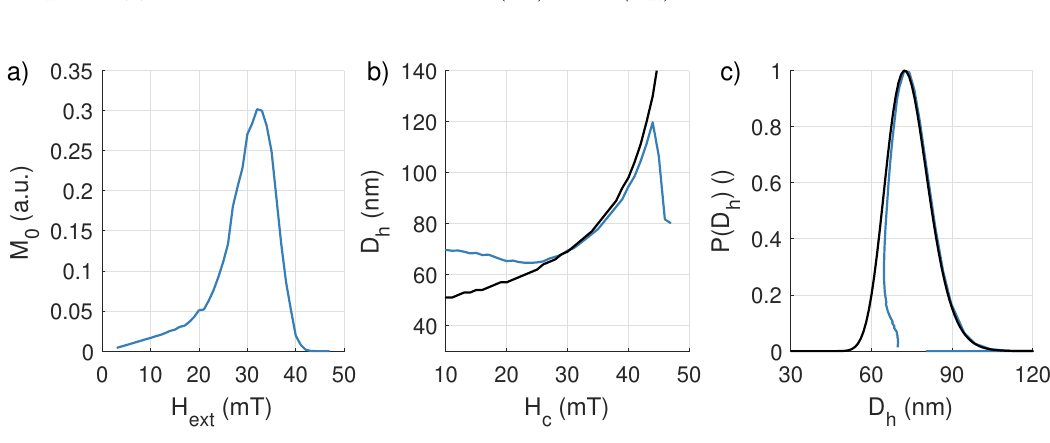
Figure 7. ( a ) Initial particle response ( M 0 ) at the end of the excitation. ( b ) Extracted D h by fitting an exponentially decaying curve to each MRX measurement. The blue line corresponds to the extracted particle size of the MRX measurements, and the black line is the actual coercivity. ( c ) The reconstructed size distribution (blue line) and the actual particle size distribution (black